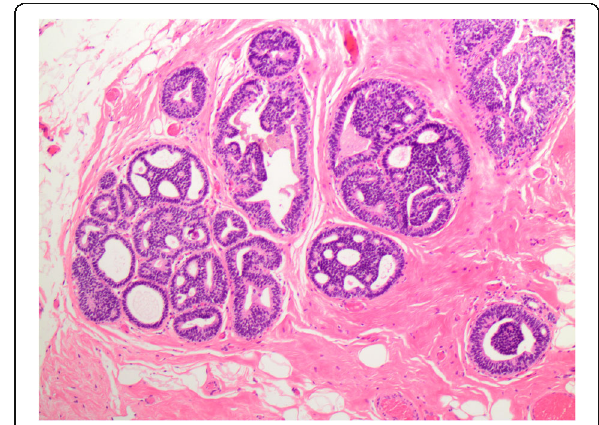
Fig. 4 Patient #2 (H&E, 10x) EXC showed ductal carcinoma in situ (DCIS)